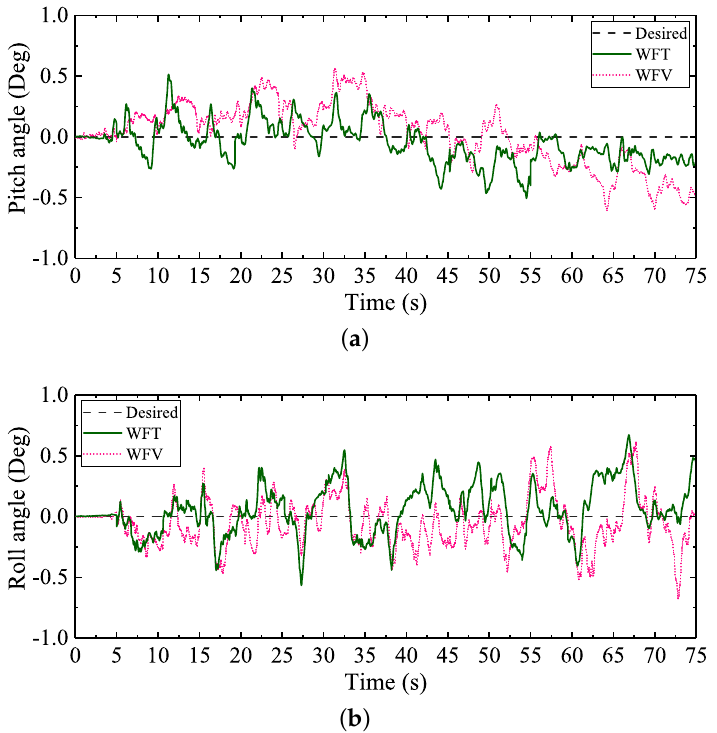
Figure 13. The attitude regulation performances of the pitch and roll angles under WFT and WFV: ( a ) the body pitch angle comparison and ( b ) the body roll angle